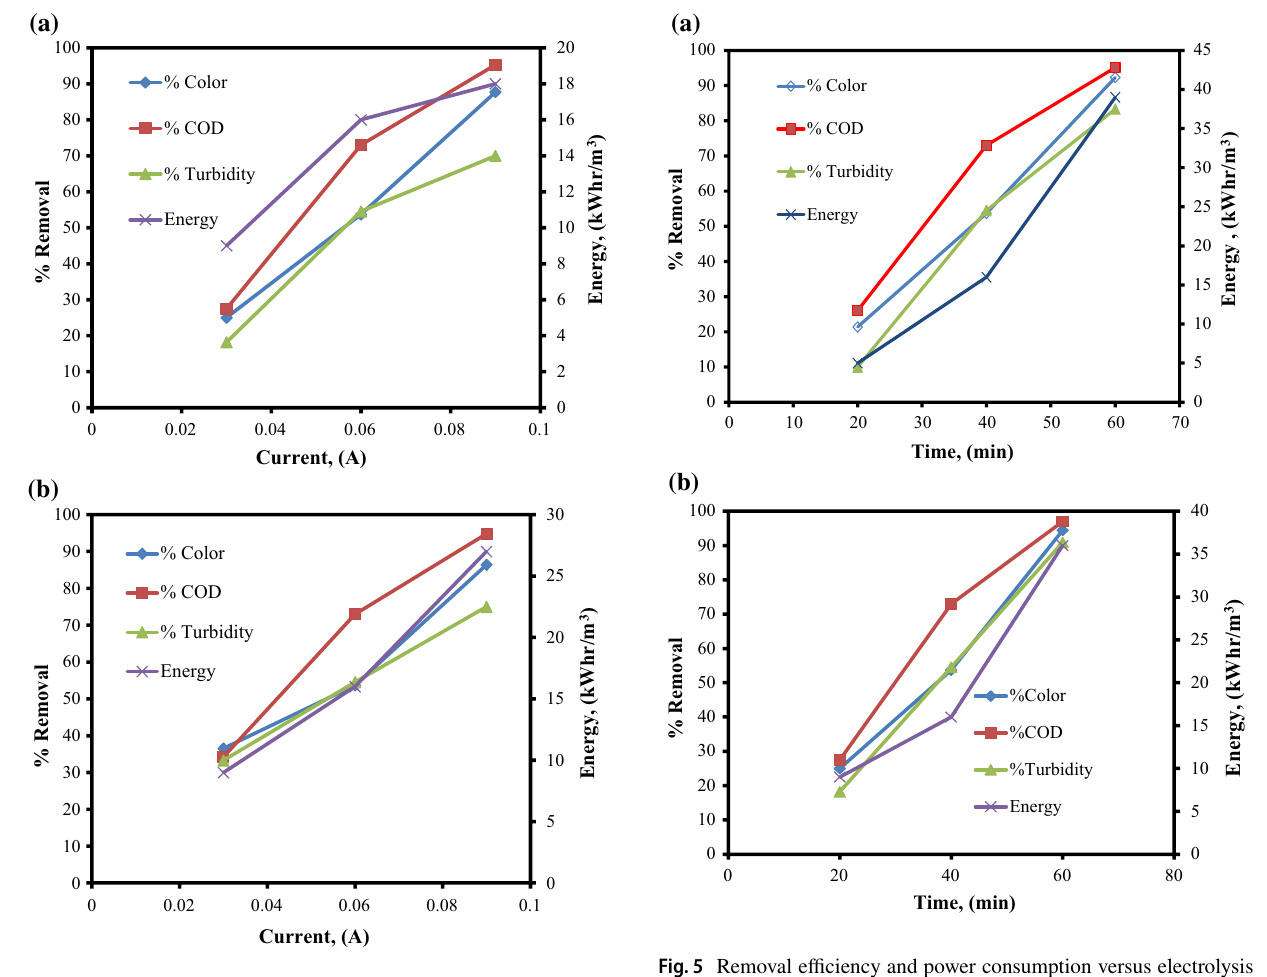
Fig. 4 Removal efficiency and power consumption versus current on